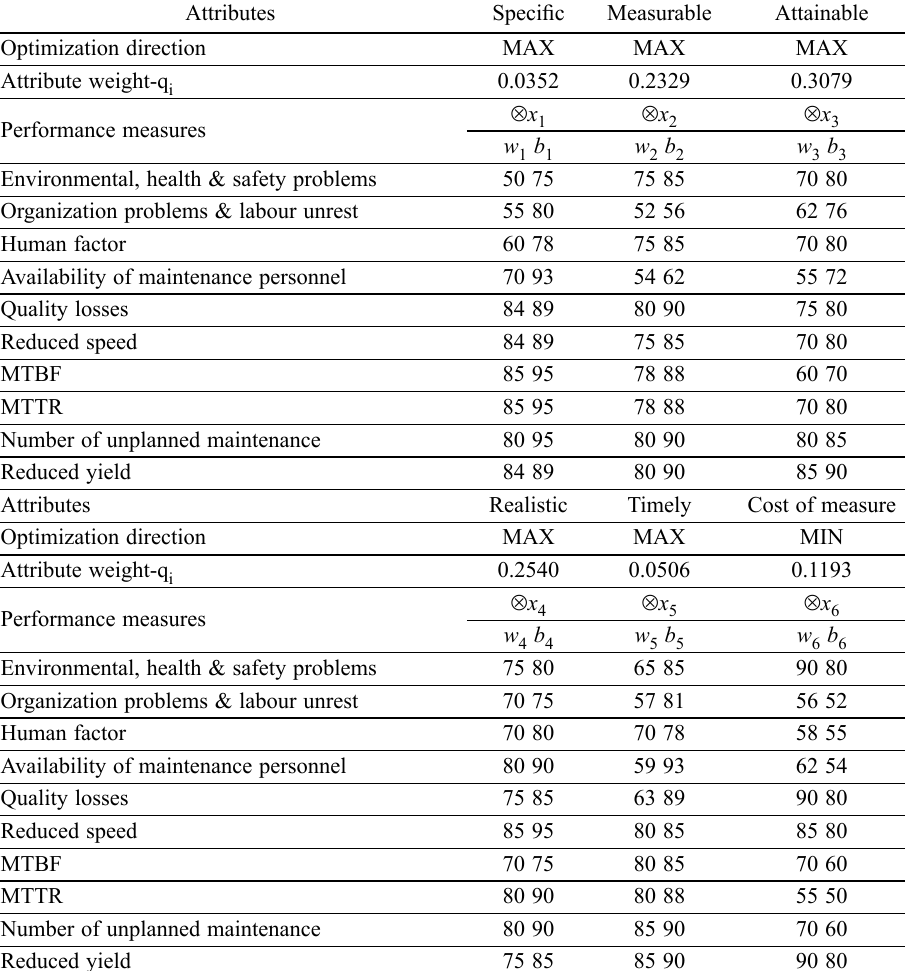
Table 5. Initial decision-making matrix with values of the attributes describing the compared alternatives in